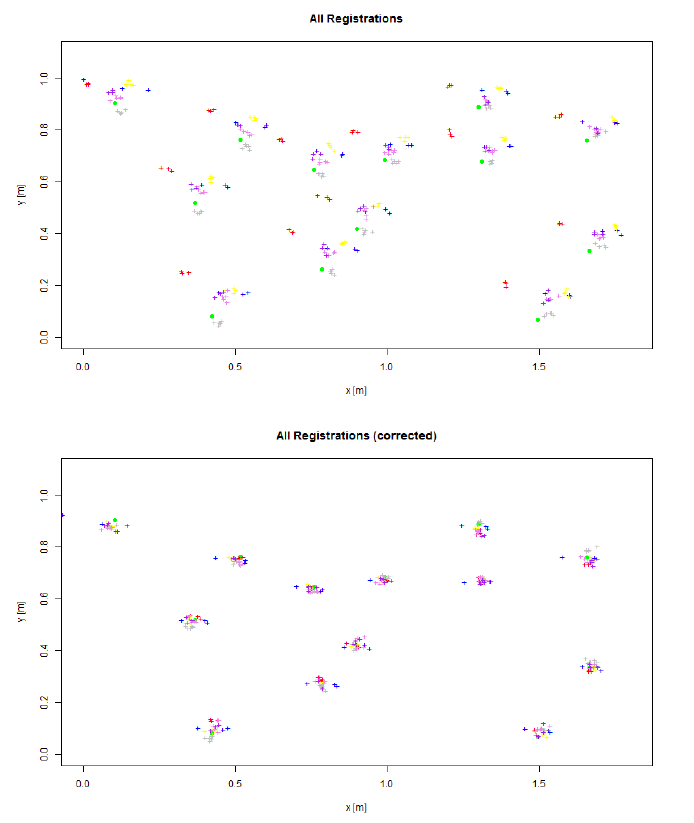
Figure 15. Plot of all measured target positions colored according to experiment sessions in comparison with ground truth positions (green). Original registrations ( top ) and measured positions after session-wise bias correction ( bottom ).